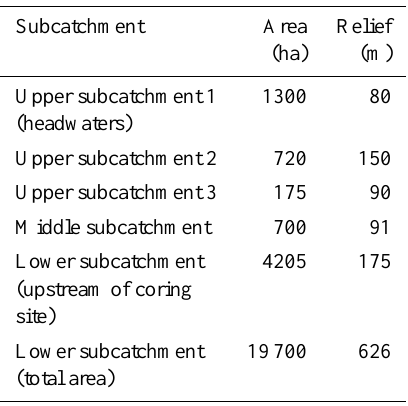
Table 3. Summary of subcatchment characteristics. See Figs. 1 and 4 for subcatchment locations.